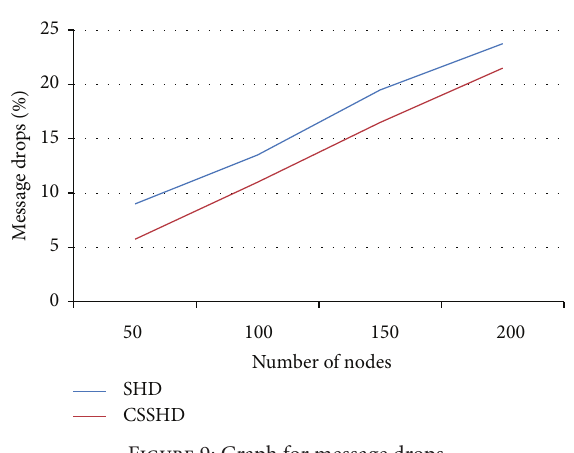
Figure 9: Graph for message drops.